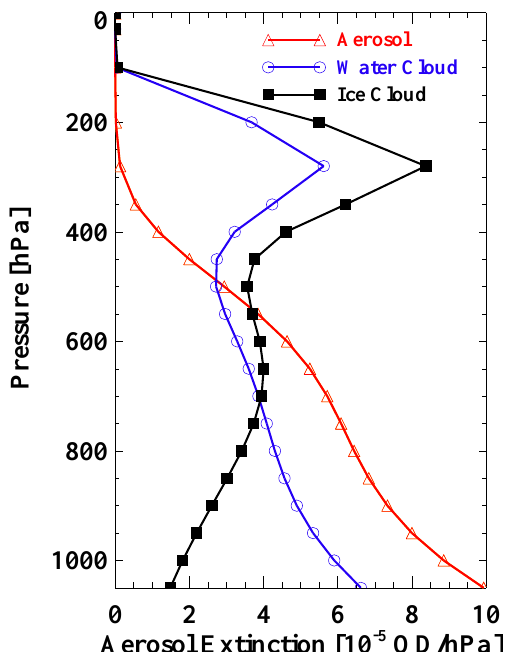
Fig. 3. A priori extinction profiles of cloud and aerosol at 0.755µm wavelength. The two formal aerosol types each have the same a pri- ori profile and are shown here as “Aerosol”. The algorithm formally retrieves the logarithm of this